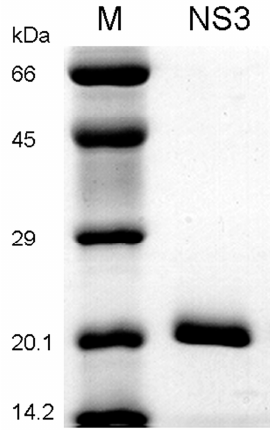
Figure 1. SDS-PAGE of purified HCV NS3 protease domain expressed in E. coli . The NS3 was purified through a Ni-NTA affinity column, followed by a heparin sepharose column, and finally a MonoS 10/10 cation exchange column. The left lane is protein size markers, and the right lane is purified NS3 (20 kDa).